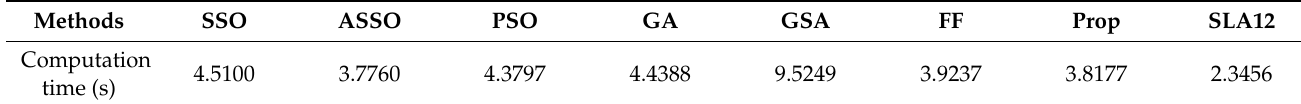
Table 6. Computational time analysis for the different feature extraction methods.